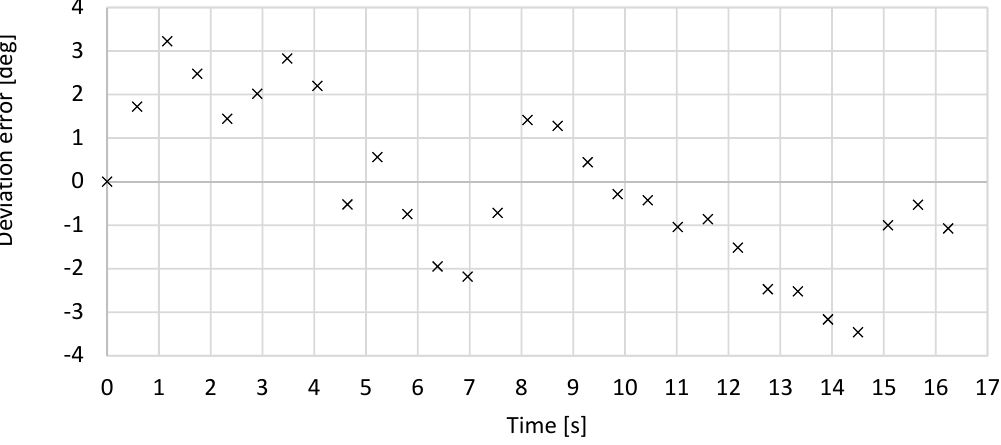
Figure 21. Comparison of δ for the test and simulation versus time. Table 3. Angular errors of the finger joints and driving links.